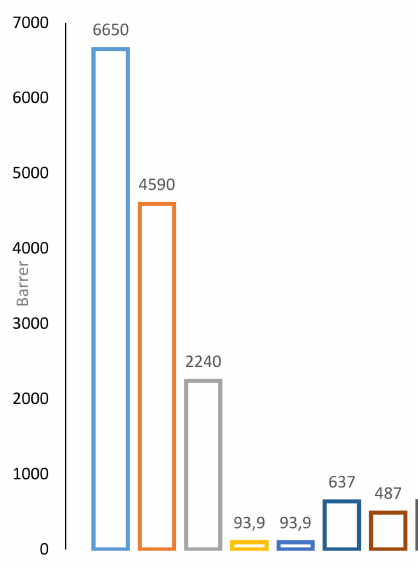
Figure 5. Permeability of CO 2 through several ILPMs